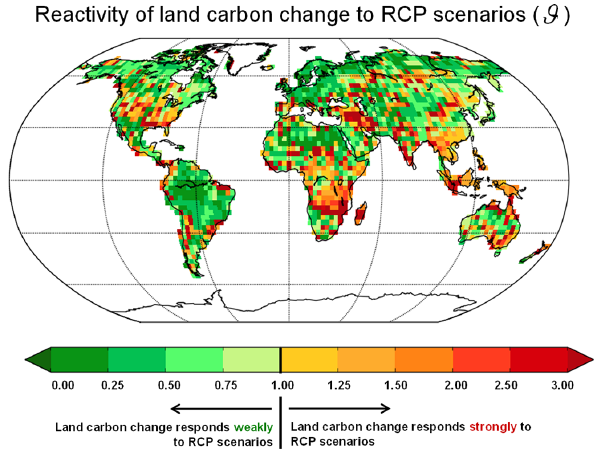
Figure 6. Geographical distribution of the reactivity ( ϑ ) of land carbon change to future climate change scenarios calculated from Eq. (9). Values less than 1 (green tones) indicate comparatively weak dependence on scenario and values greater than 1 (orange and red tones) indicate strong dependence on